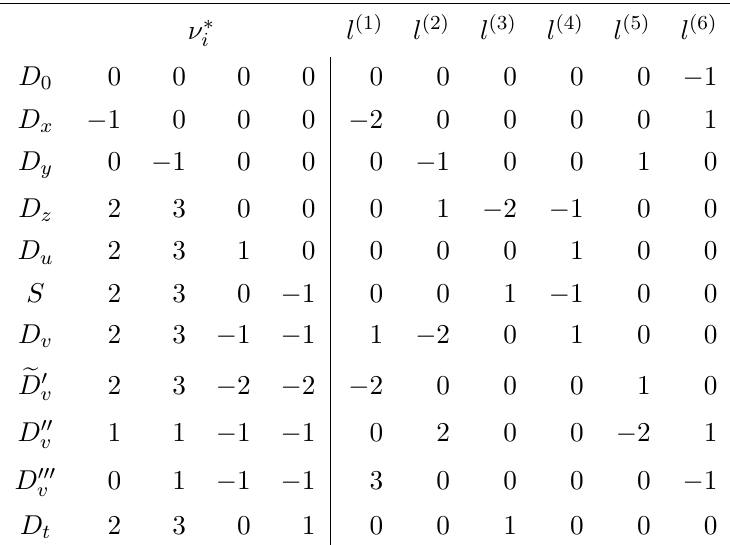
Table 5 . Toric divisors and Mori cone generators of the toric variety whose anti-canonical divisor is the compact embedding of the E-string geometry with three (cid:13)avor masses turned on breaking SO(7) (cid:26) E 8